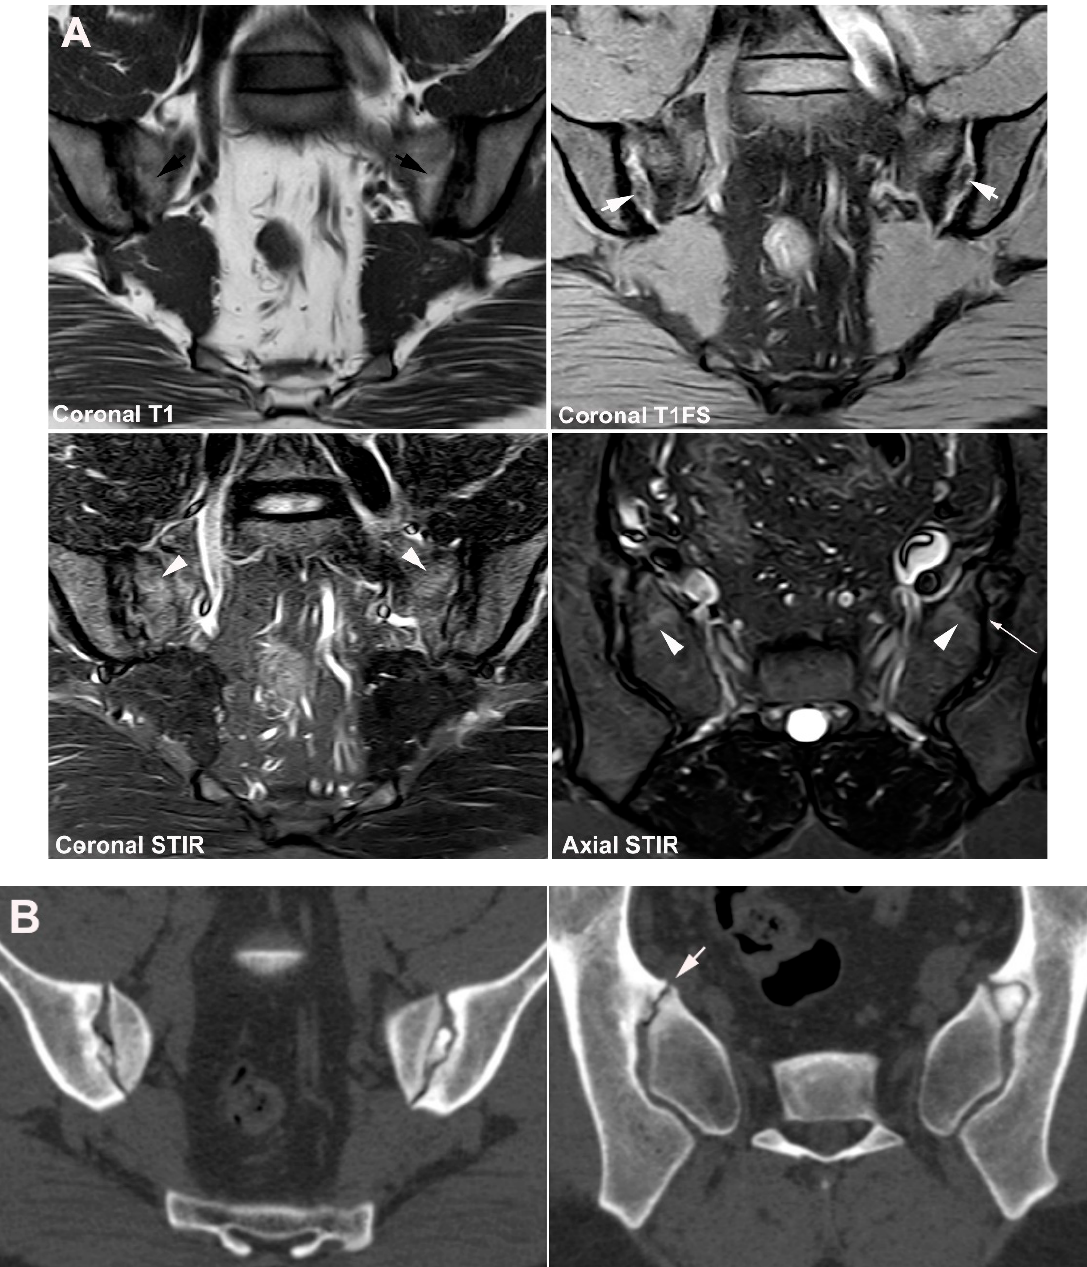
Figure 12. Atypical fusion of nucleus in a 24-year-old man with right-sided buttock pain for 8 months. Semi-coronal T1, T1FS and STIR, and semi-axial STIR images at the border between S1 and S2. At the right SIJ there is a relative hypertrophic nucleus at the border between S1 and S2 which has fused with the ileum and not as normally with the sacral bone (white arrows). It causes an indentation in the sacral bone with a surrounding brim of edema (arrowheads), focal irregular joint margins and fat deposition (black arrows on T1).